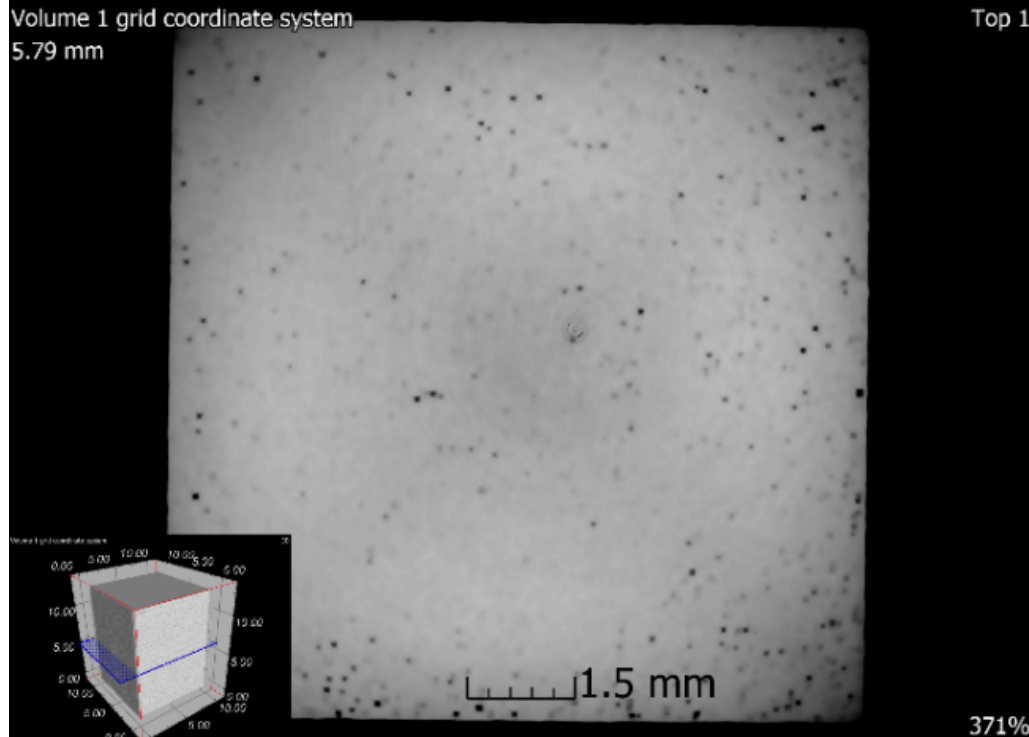
Figure 19. Tomographic CT sections of sample 5 after SLM + HIP_2 (XZ plane). Materials 2020 , 13 , x FOR PEER REVIEW